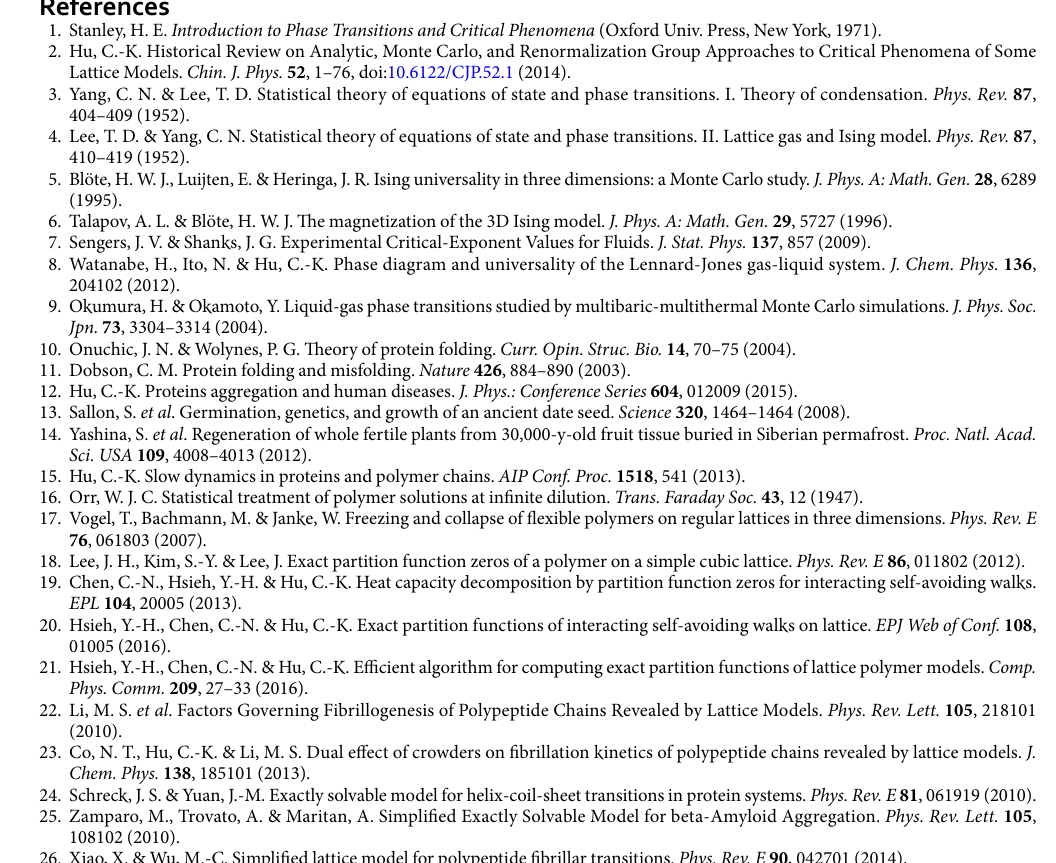
for i = 0, 1 and 2, where Ξ = x ( ) 1 if and only ≠ x 1 . The decreasing in the values of R 0 , R 1 and R 248, 49 signal the entering of stages II, III and IV, respectively (in Fig. 1(d)). Stage II specifies the longitudinal growth to have ribbon-like local structures. The orderings in stages III and IV are in transverse directions to form belt-like (two-dimensional) and bundle-like (three-dimensional) structures, respectively. The initiation of the aggregation process is signaled by a rapid falling in R 0 , corresponding to the triggering of parallelized segments. It is followed by the growths in transverse directions. Since the systems under consideration in this study are dilute in polymer concentration, it is insufficient to form extended planar crystal structures 50 and, instead, the chains grow into bundles 48, 49 (Fig. 7). It is these parameters that are used to determine the schematic diagram of steady phases in Fig. 1(e). We list the notations for interaction potentials, parameters and statistical quantities in Tables 1, 2 and 3, respectively.